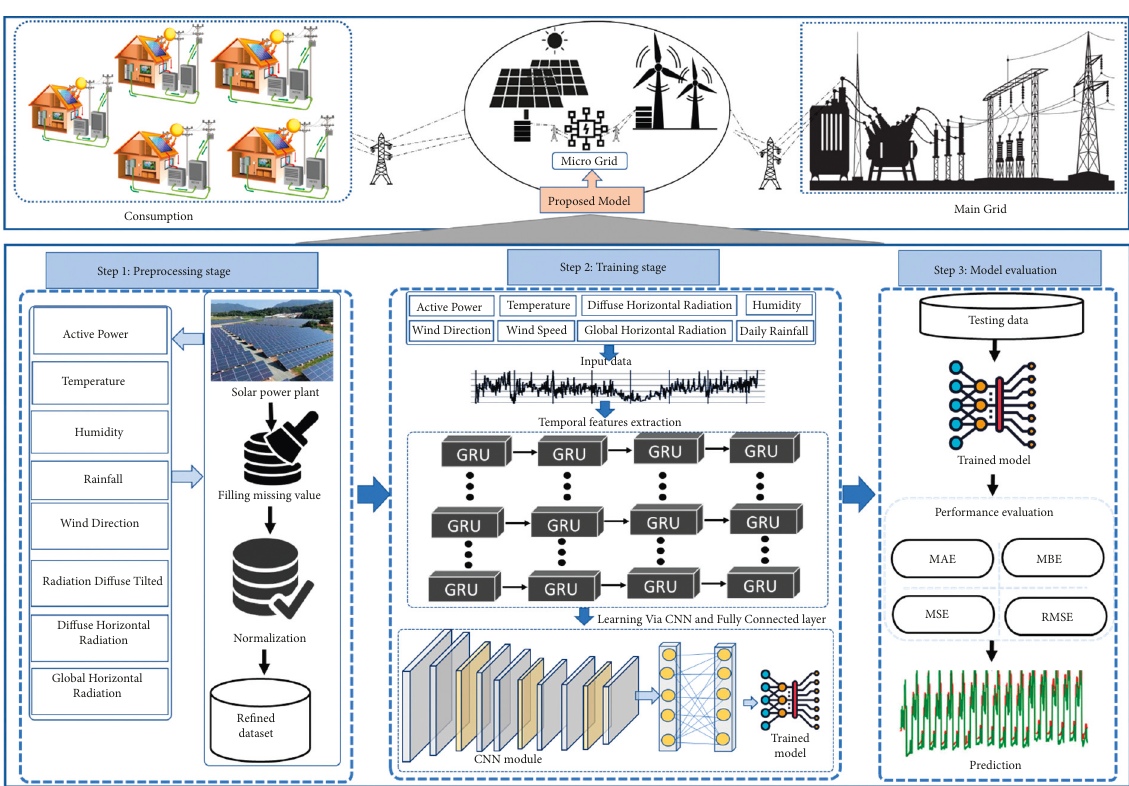
Figure 1: The proposed PV power forecasting framework comprises mainly three steps. Step 1: Preprocessing is applied to normalize the data, remove outliers, and fill in missing values. Step 2: Model selection with the refined data using the GRU and CNN networks. Step3: Evaluate the model via metrics, including MSE, MAE, RMSE, and